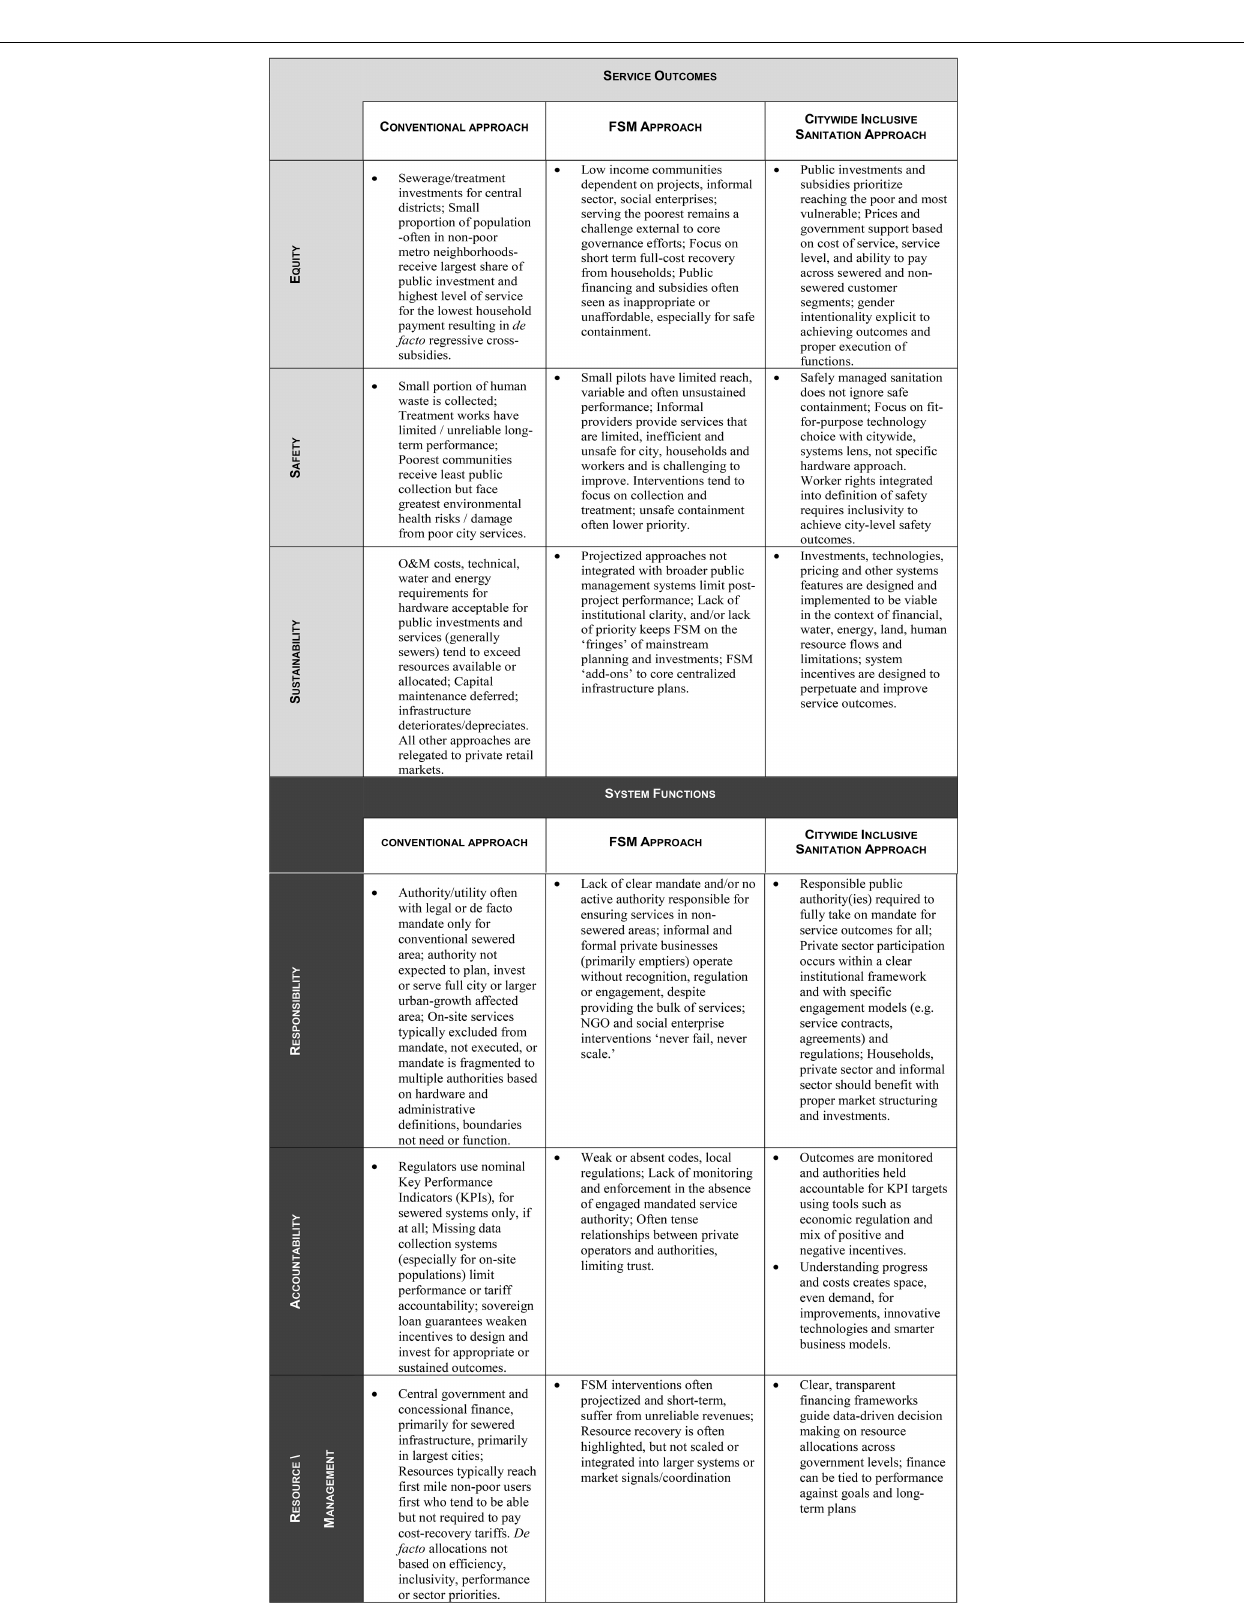
Frontiers in Environmental Science |